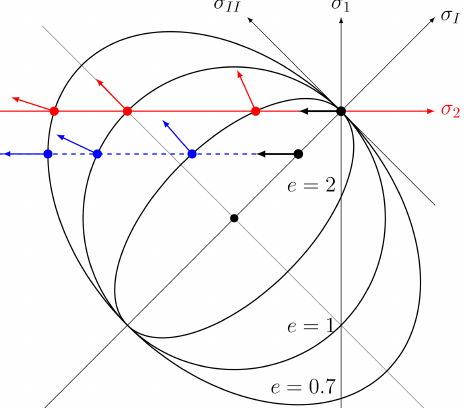
Figure 4. Schematic of stress states and failure in principal stress space. Black arrows show how stresses move from zero at the be- ginning of loading towards the yield curve until failure. Red points show the stress states at failure – the intersection point between the second principal axis 2 (in red) and the elliptical yield curve – for different ellipse ratios e = 2, 1, 0.7. The red arrows show the direc- tion of deformation with a normal flow rule. The blue points and arrows show the case when the ice floe is confined and the loading will lead to extra stress in the direction of σ 1